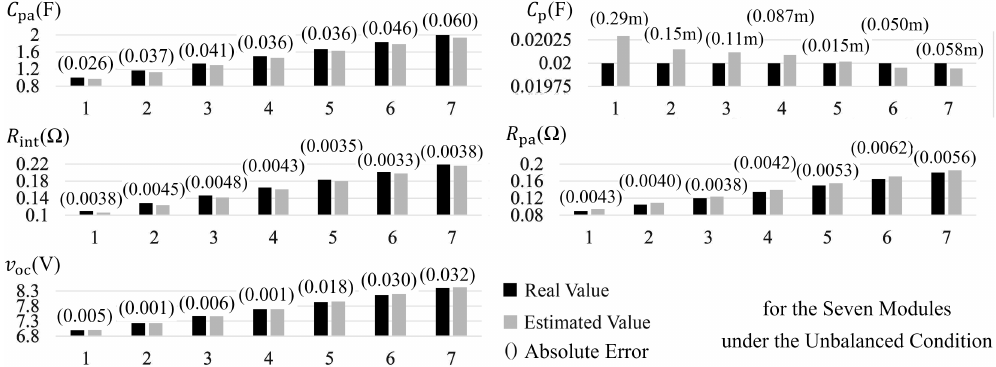
Figure 8. Estimation of the five parameters for the seven modules under the unbalanced